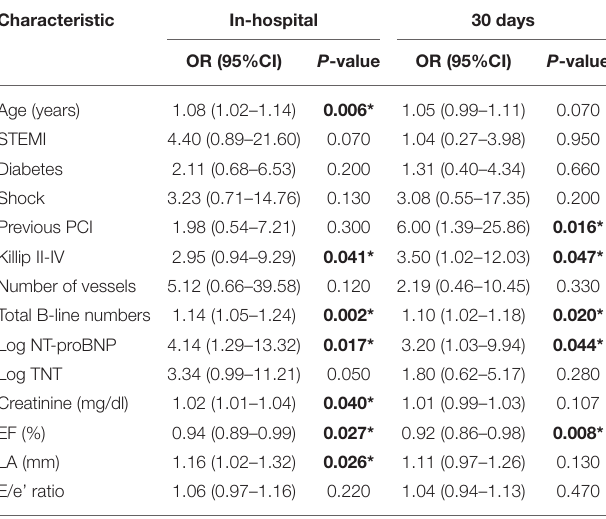
TABLE 2 | Univariate analysis for in-hospital and 30 days composite outcome. Characteristic